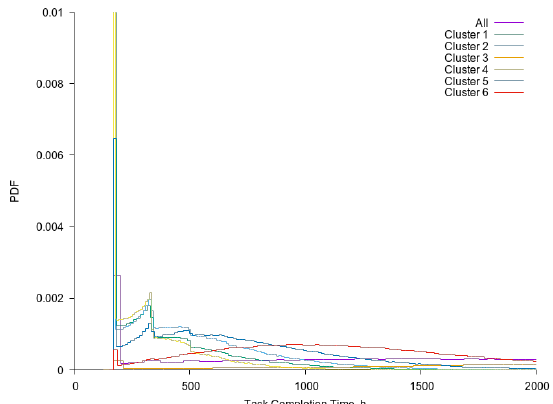
Figure 3: Task completion time probability density distributions for each cluster. The task complexity T = 168h (1 week).